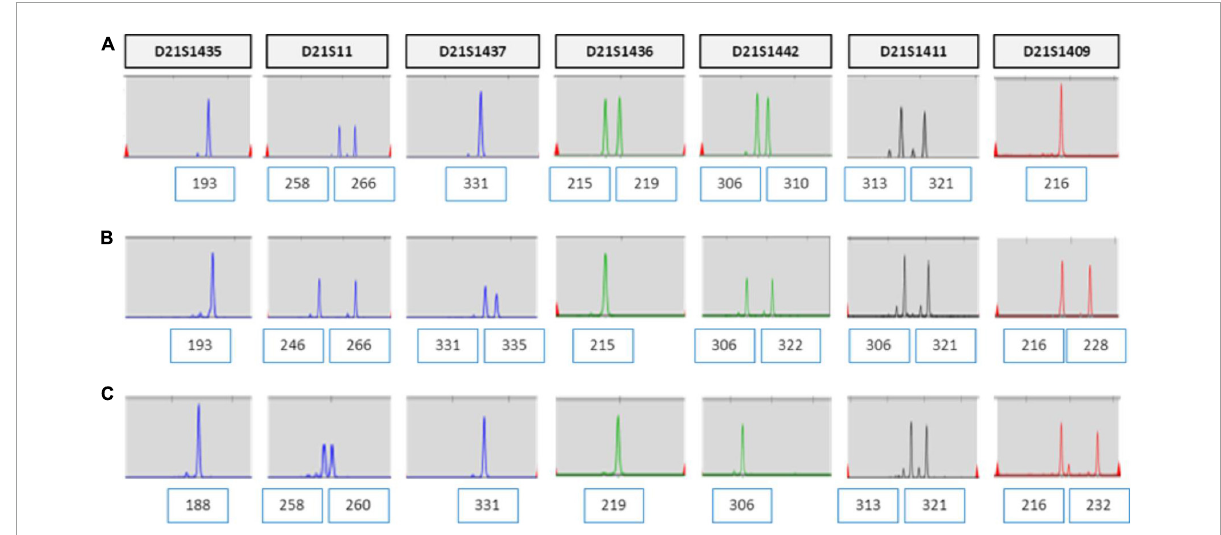
FIGURE3 UPD test for chromosome 21 using QF-PCR in case 1. (A) Fetus allele in uncultured amniocytes; UPD of chromosome 21 was not detected. (B) Maternal allele in peripheral blood. (C) Paternal allele in peripheral blood.